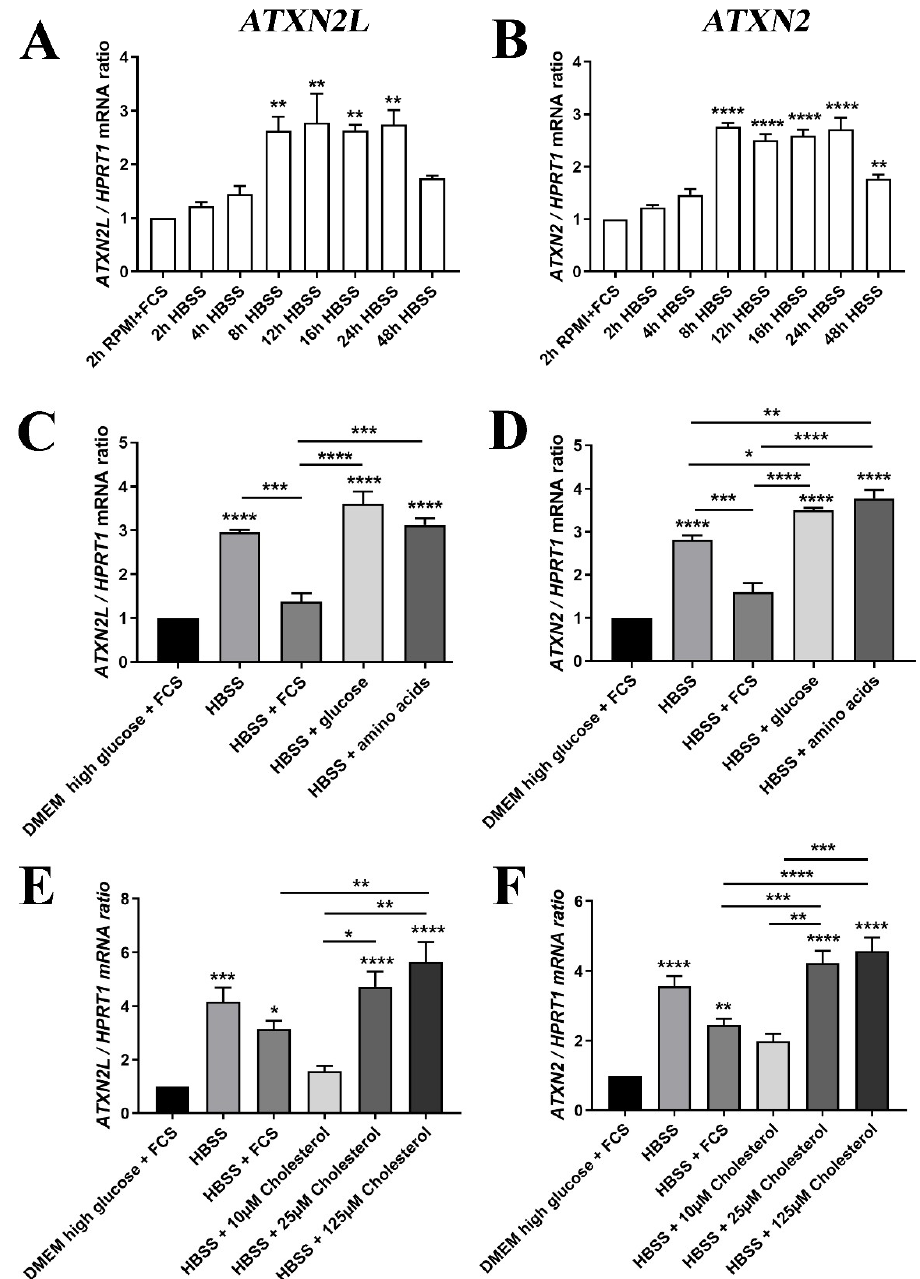
Figure 7. ( A ) The mRNA expression of ATXN2L in human SH-SY5Y neuroblastoma cells was induced by nutrient deprivation in HBSS medium over 48 h with low glucose/no amino acids, in the absence of lipids normally supplied via FCS, similar to the expression of ( B ) ATXN2 mRNA. ( C ) For the induction peak at 24 h, the expression upregulation of ATXN2L was partially prevented upon supplementation of 10% FCS, while glucose or amino acids alone had no rescue effect; ( D ) FCS addition also diminished ATXN2 expression, while glucose and amino acid administration enhanced the expression further; ( E ) The HBSS induction of ATXN2L was reduced at least as much by low cholesterol concentrations as by FCS, while higher dosage of cholesterol elicited even stronger upregulations. ( F ) This effect was similarly observed for ATXN2. A-D: n = 3; E/F: n = 8. Statistical testing was done by one-way ANOVA, significance levels were illustrated by asterisks: * p < 0.05; ** p < 0.01; *** p < 0.001; **** p < 0.0001. Comparison was always in respect to nutrient abundant control condition, if not stated otherwise.